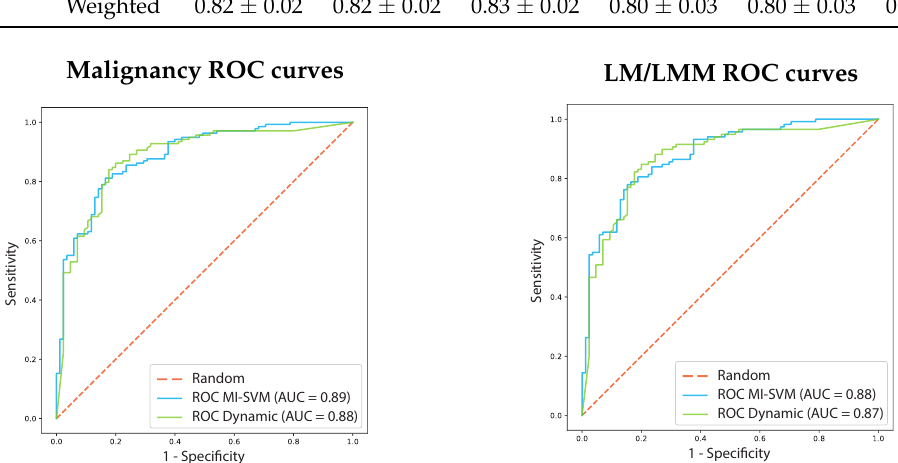
Figure 5. On the left , the ROC curves for Malignancy with the Dynamic and MI-SVM methods. On the right , the ROC curves for LM/LMM with the Dynamic and MI-SVM methods.